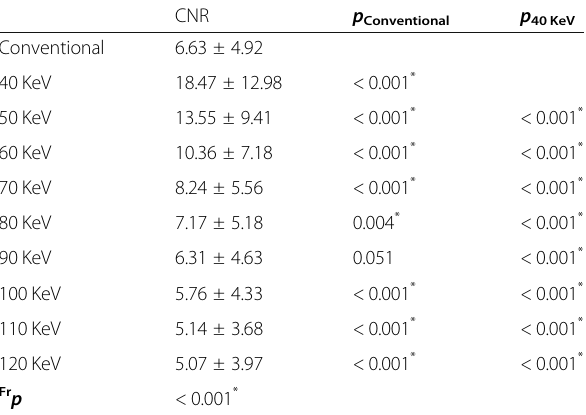
Table 3 Quantitative analysis of image sets (conventional polyenergetic images and VME images 40 – 120 KeV)